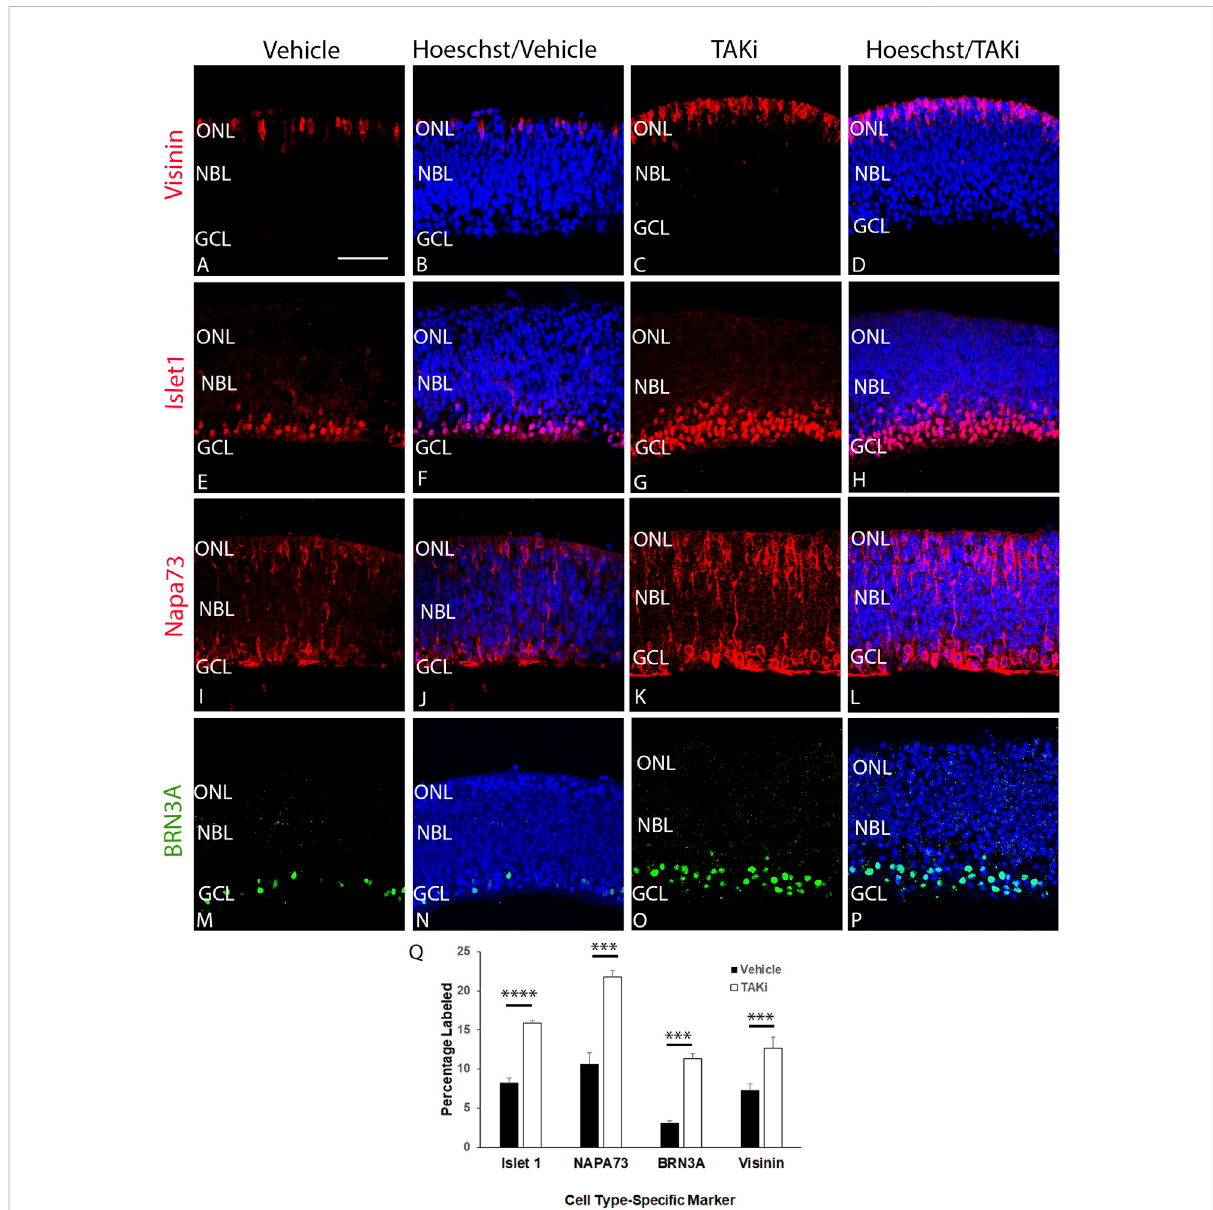
Sections through TAKi-treated retinas show an increased percentage of cells expressing cell type-speci fi c markers Visinin, Islet1, NAPA73, and BRN3A incomparisonto vehicle-treated retinas.E6 chickretinal cultures weretreated withvehicleor2 μ MTAK1inhibitor(Sanjo etal., 2019)for24h and sections through retinas were co-labeled with Hoechst dye (DNA; blue) and visinin (A – D) , islet1 (E – H) , napa73 (I – L) , or BRN3A (M – P) . Abbreviations: NBL, neuroblast layer; GCL, ganglion cell layer. Scale bar in A = 50 μ m for images (A – P) . Quantitation of the percentage of labeled cells in vehicle and TAKi-treated retinas is shown in (Q)